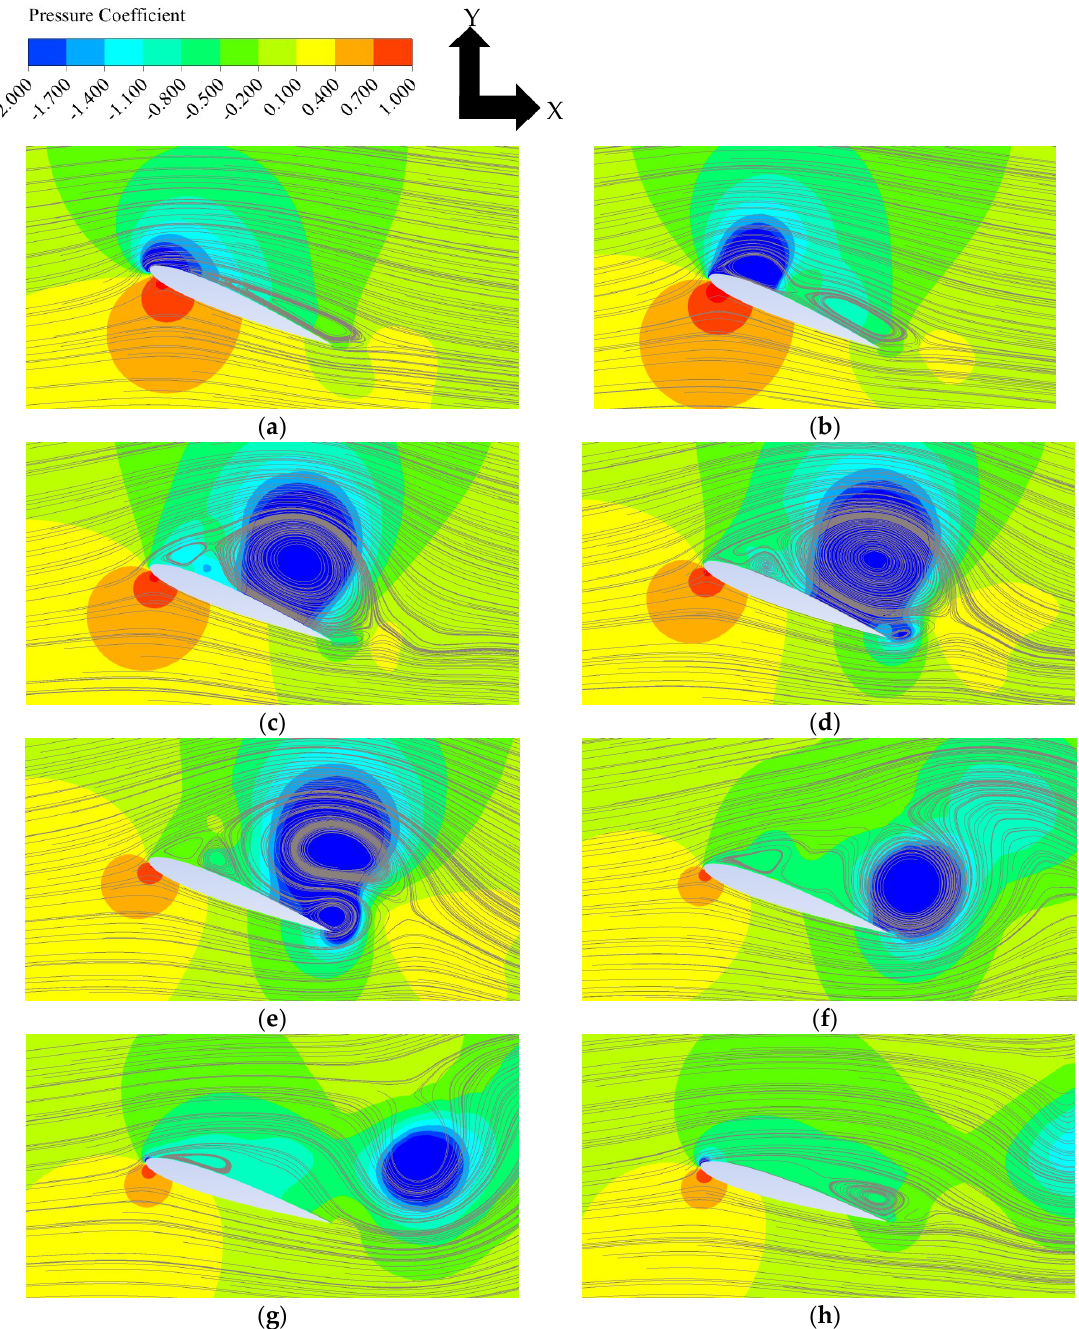
Figure 7. Pressure field and stream lines around the aerofoil. Maximum AoA = 23°, f = 0.1. ( a ) AoA = 22.90° ↑ ; ( b ) AoA = 22.99° ↓ ; ( c ) AoA = 22.28° ↓ ; ( d ) AoA = 21.92° ↓ ; ( e ) AoA = 21.50° ↓ ; ( f ) AoA = 19.83° ↓ ; ( g ) AoA = 18.42° ↓ ; ( h ) AoA = 16.81° ↓ .